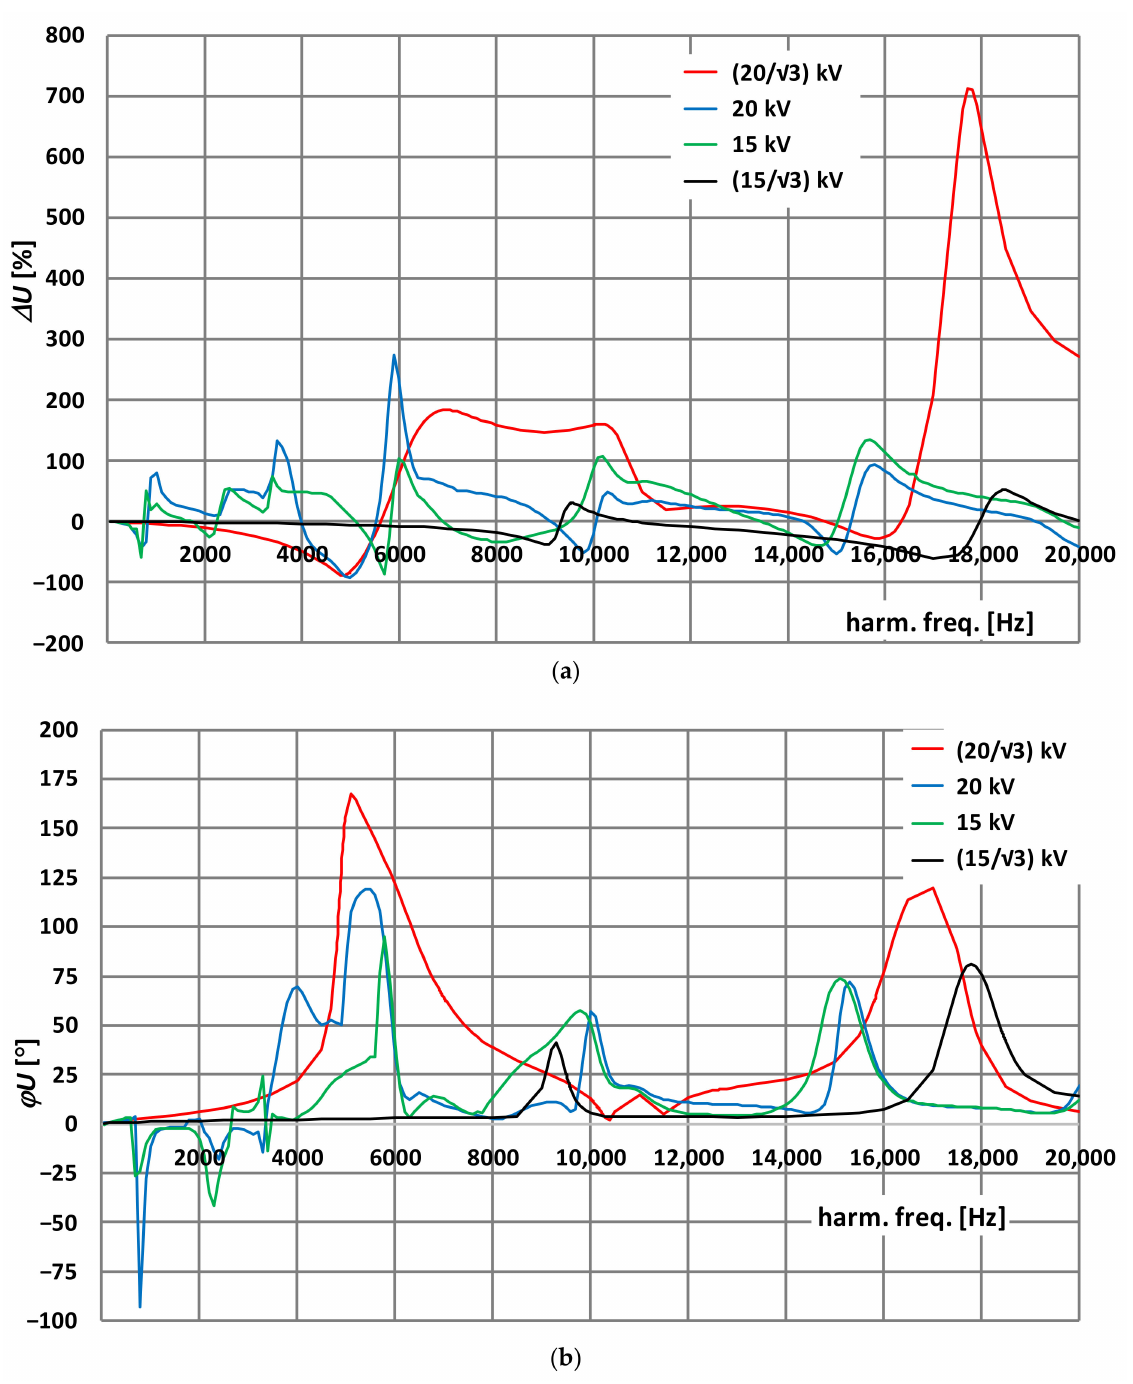
Figure 10. Application of sinusoidal voltage of frequency from 20 Hz to 20 kHz to determine the resonance frequency(ies) of all tested VTs: ( a ) voltage error, ( b ) phase